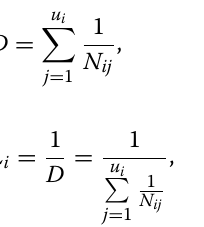
Table 1 Material properties of GH4133, 1Cr11Ni2W2MoV, and